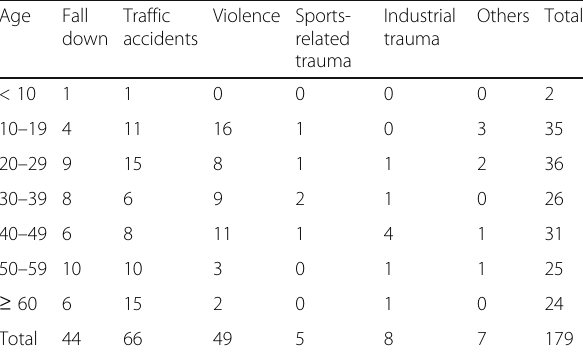
Table 3 Cause of injury according to age